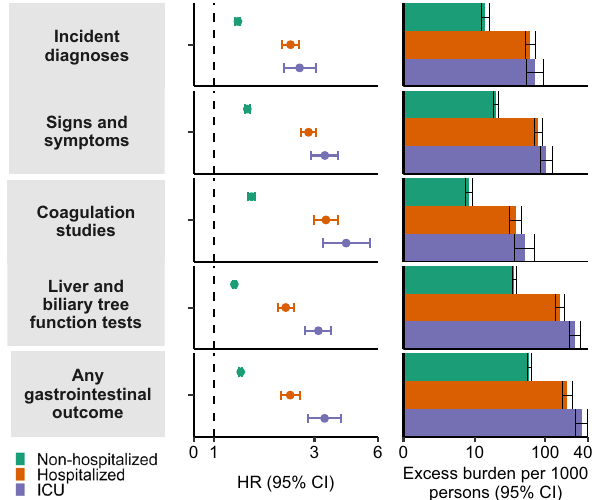
Fig. 5 | Risks and 1-year burdens of incident post-acute COVID-19 composite gastrointestinal outcomes compared with the contemporary control cohort bycaresettingoftheacuteinfection. Risksandburdenswereassessedat1-yearin mutually exclusive groups comprising non-hospitalized individuals with COVID-19 (green),individualshospitalizedforCOVID-19(orange)andindividualsadmittedto intensive care for COVID-19 during the acute phase ( fi rst 30 d) of COVID-19 (blue). Composite outcomes consisted of incident diagnoses (GERD, PUD, acute pan- creatitis, functional dyspepsia, acute gastritis, IBS, and cholangitis), signs and symptoms (constipation, abdominal pain, diarrhea, vomiting, and bloating), coa- gulation studies (PT, PTT, INR), liver and biliary tree function tests (albumin, ALT, total protein, AST, LDH, CRP, ALP, total bilirubin, GGT, direct bilirubin, lipase, and amylase) and any gastrointestinal outcome (incident occurrence of any gastro- intestinal outcome studied). Outcomes were ascertained 30 d after the COVID-19- positivetestuntiltheendoffollow-up.Thecontemporarycontrolcohortservedas the referent category. Within the COVID-19 cohort, non-hospitalized ( n = 131,915), hospitalized( n = 16,764),admittedtointensivecare( n = 5389)andcontemporary control cohort ( n = 5,606,761). Adjusted HRs (dots) and 95% (error bars) CIs are presented,asareestimatedexcessburdens(bars)and95%CIs(errorbars).Burdens arepresentedper1000personsat12monthsoffollowup.Thedashedlinemarksa HR of 1.00; lower limits of 95% CIs with values greater than 1.00 indicate sig- ni fi cantly increased risk. GERD gastroesophageal re fl ux disorder, IBS, irritable bowel syndrome, PT prothrombin time, PTT partial thromboplastin time, INR international normalized ratio, ALT alanine transaminase, AST aspartate transa- minase, LDH lactate dehydrogenase, CRP c-reactive peptide, ALP alkaline phos- phatase, GGT γ -glutamyl